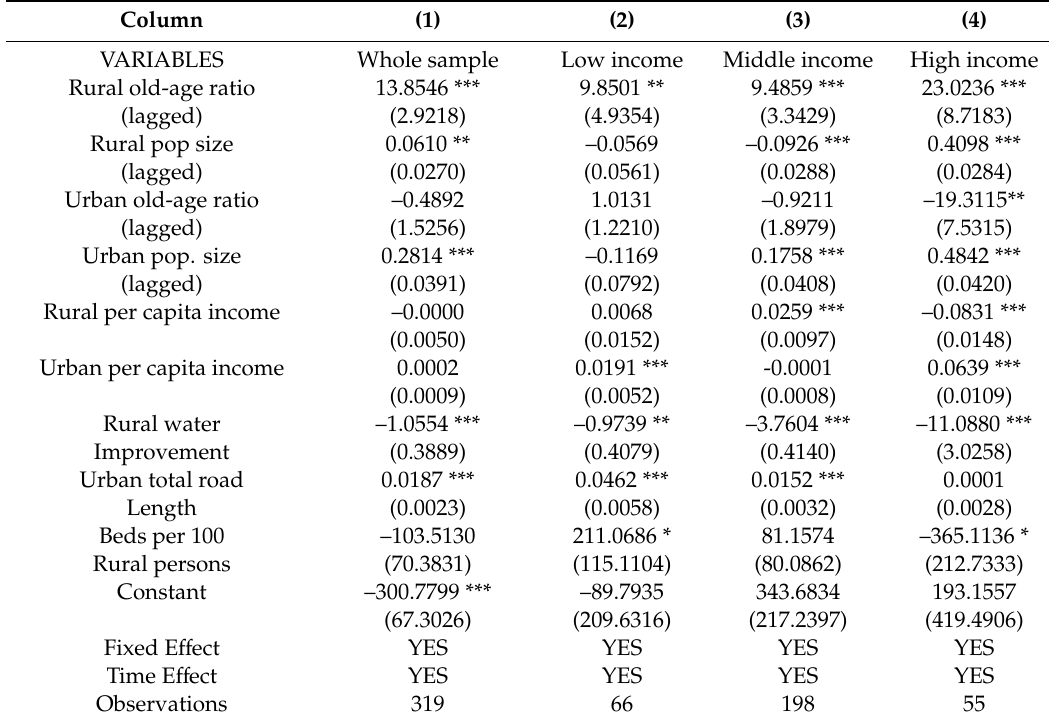
Table 2. Rural old-age ratio and inpatient visits to the urban hospitals.